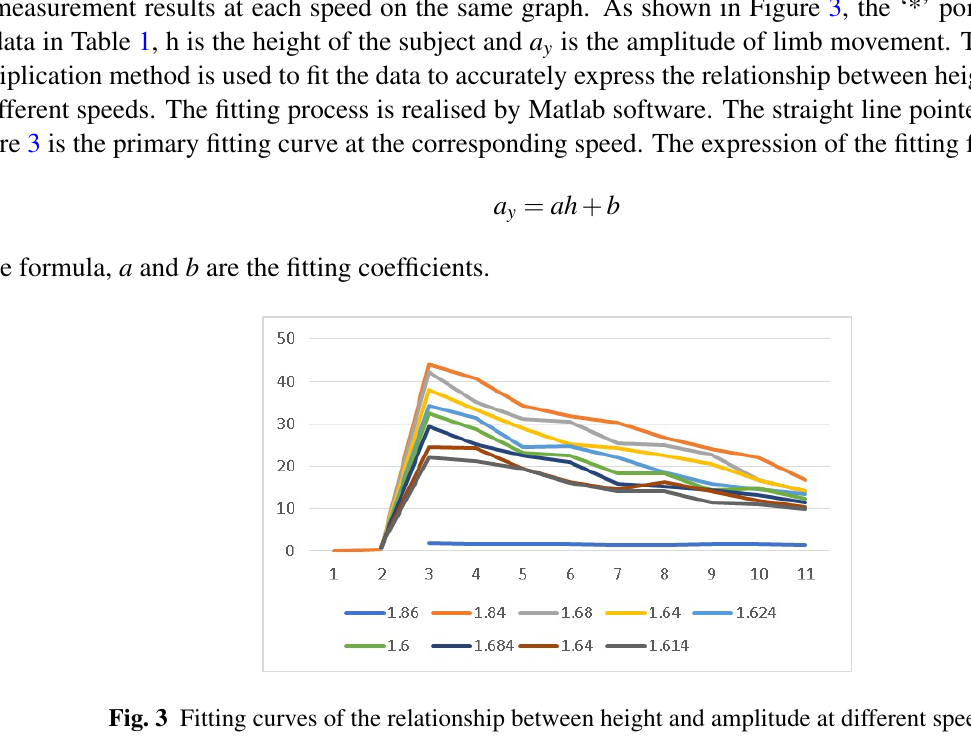
Fig. 3 Fitting curves of the relationship between height and amplitude at different speeds.